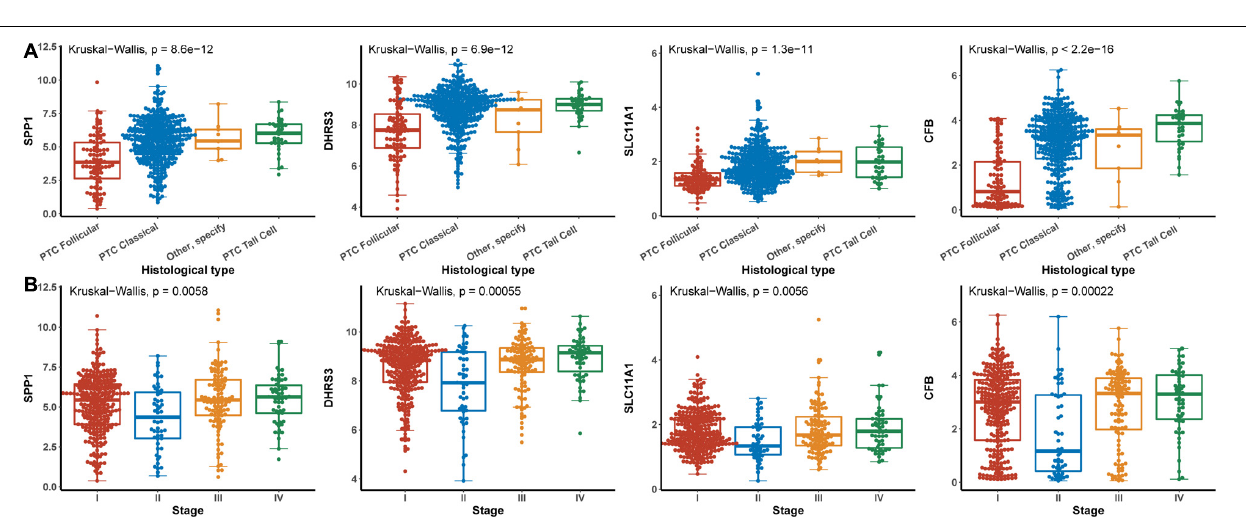
FIGURE 3 | Identification of genes associated with M1 macrophages. (A) LASSO coefficient profiles of the prognostic-related candidate hub genes. (B) Relationship between partial likelihood deviance and log( λ ). (C) Expression of the hub genes in GEPIA. (D) Univariate Cox analysis of the hub genes. * P -values < 0.01.